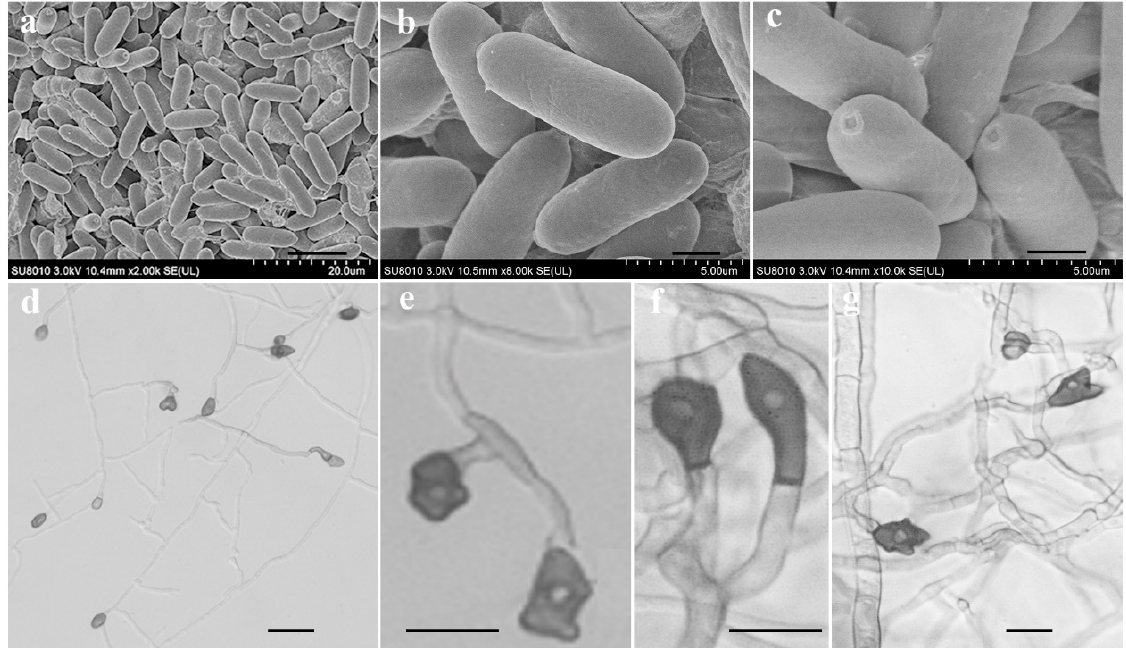
Figure 3. Conidia and appressorium characteristics of isolate LVY 9 on PDA. Conidia are smooth- walled, hyaline, and cylindrical, with obtuse to slightly rounded ends ( a – c ). Bars = 10, 2, 1 µm, respectively; appressoria appear brown to dark brown, ovoid, clavate, and slightly irregular in shape( d – g ). Bars = 20, 10, 10, 5 µm, respectively.